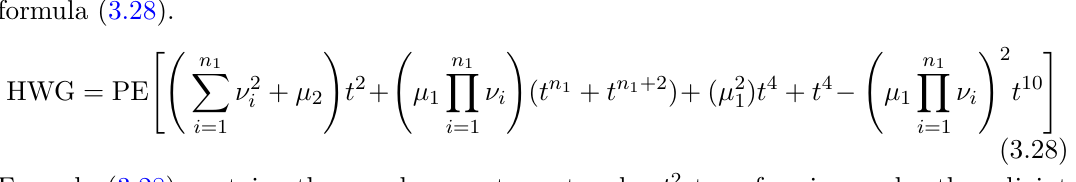
for the family of fP formula